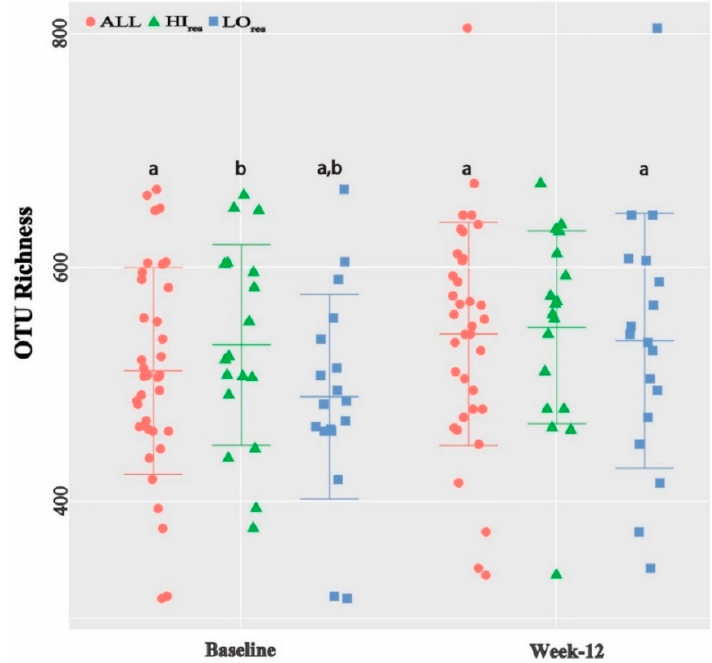
Figure 3. OTU-richness relate with weight-loss response. Data shown as mean ± SE with individual data point distribution. a (within group change) and b (difference between groups at a given time point) indicate p < 0.05; HI, high; LO, low; res, response groups.